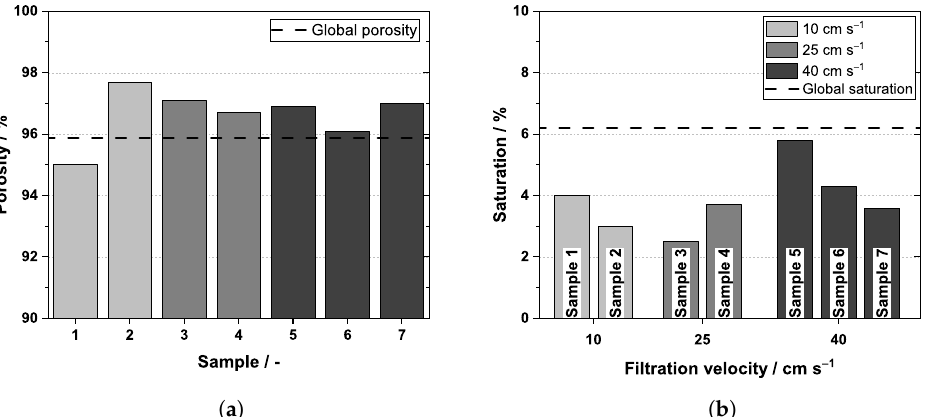
Figure 6. ( a ) Local and global porosity of the filter material without oil (unloaded) for Samples 1–7. ( b ) Local and global saturation for filtration velocities of 10, 25 and 40cms − 1 for Samples 1–7. The global porosity and global saturation are indicated by dashed